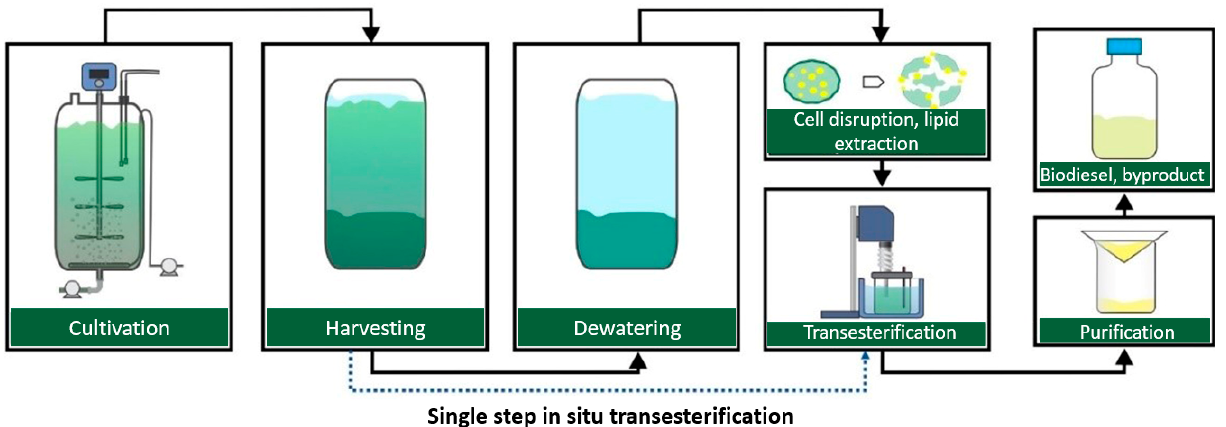
Figure 3. Processes involved in the production of biodiesel from microalgae. In situ transesterification is done generally by mixing alcohol and catalyst with the wet microalgae, allowing the production of biodiesel without undergoing dewatering and lipid extraction processes individually (adapted from [62]).